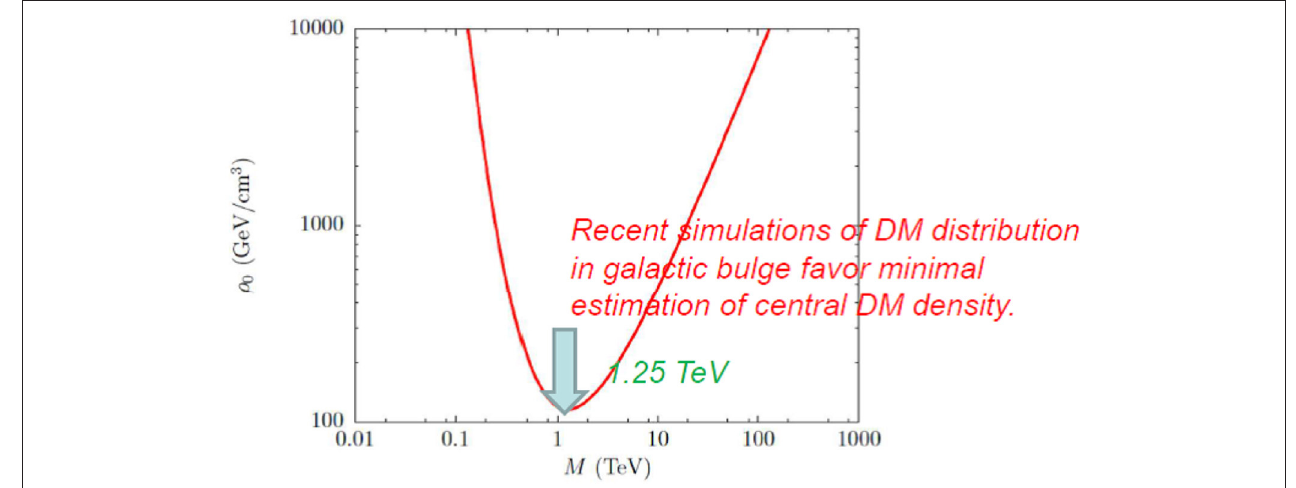
FIGURE 1 | Dark matter is subdominant in the central part of Galaxy. It strongly suppresses it dynamical effect and causes large uncertainty in dark matter density and velocity distribution. At this uncertainty one can explain the positron line excess, observed by INTERGRAL, for a wide range of m o given by the curve with minimum at m o 1.25TeV. However, recent analysis of possible dark matter distribution in the galactic bulge favor minimal value of its central density. The picture is = taken with the according permission from Bulekov et al.